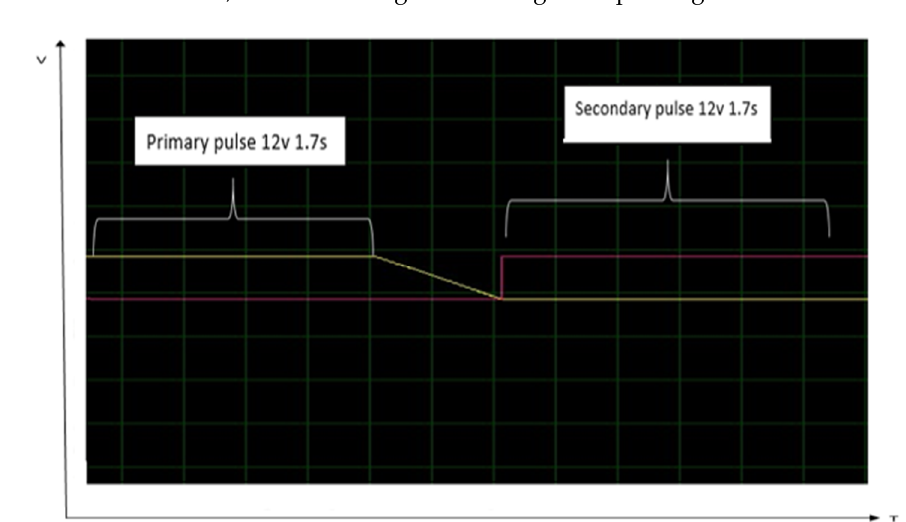
Figure 12. Primary and secondary pulse on stations for observing phase shift.